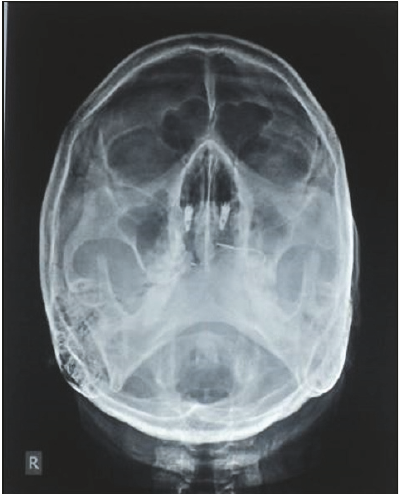
Figure 8: Postoperative PNS water’s view radiograph showing implant in